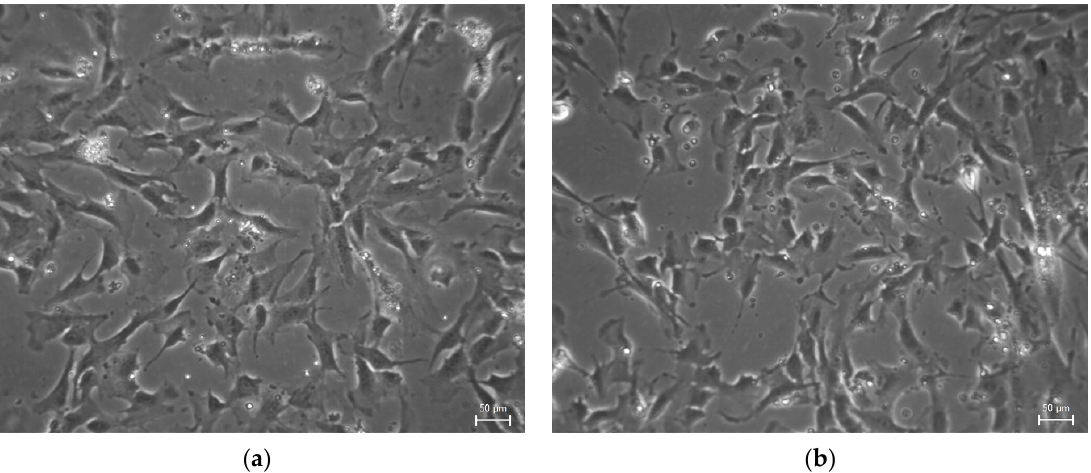
Figure 1. The rounded spindle-like shape of hNDP-SCs, cultivated for 14 days upon their isolation. Scale bar 50 µ m: ( a ) hNDP-SCs cultivated in the FBS-culture medium; ( b ) hNDP-SCs cultivated in the hPL-culture